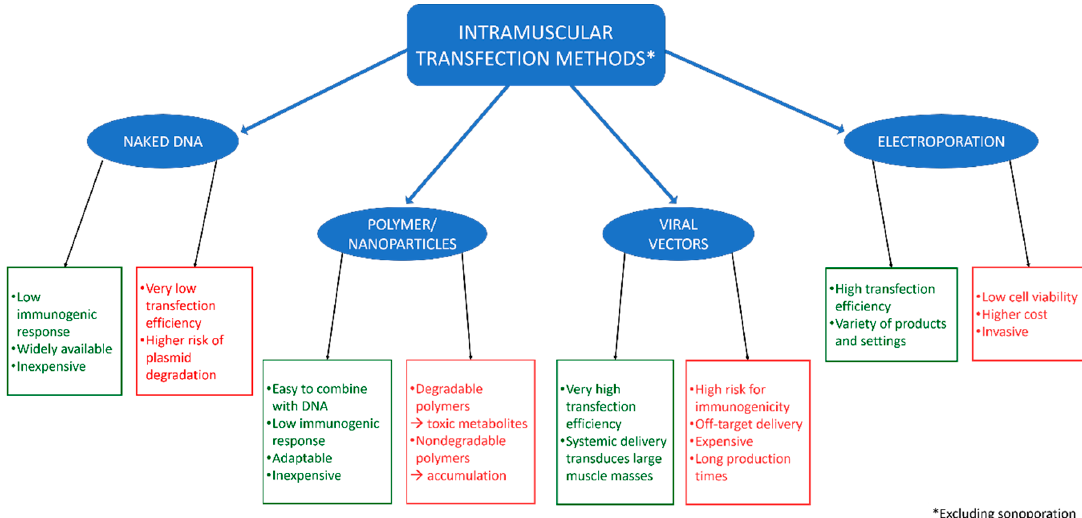
Figure 1. Common approaches for delivery of plasmid DNA into skeletal muscle and their associated advantages (green) and disadvantages (red).